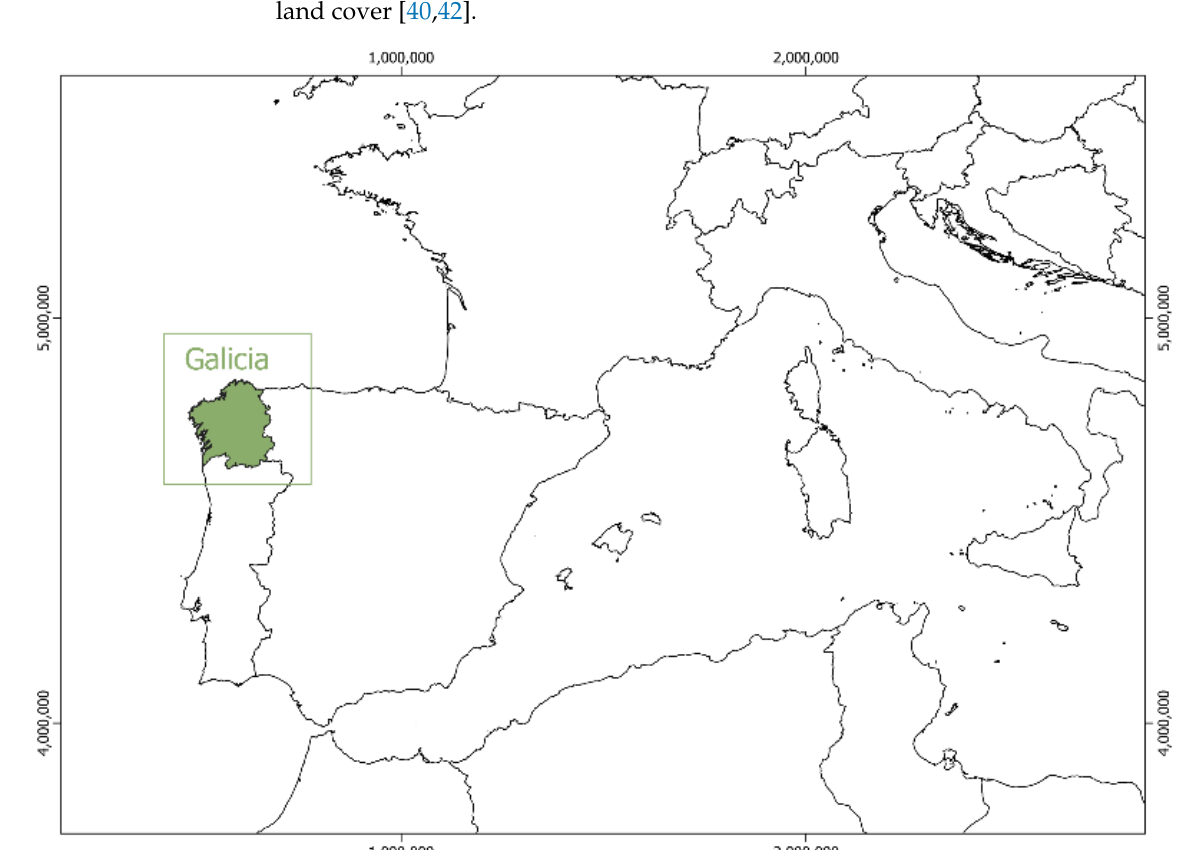
Figure 1. Study area. Galicia (Northwest of Spain).